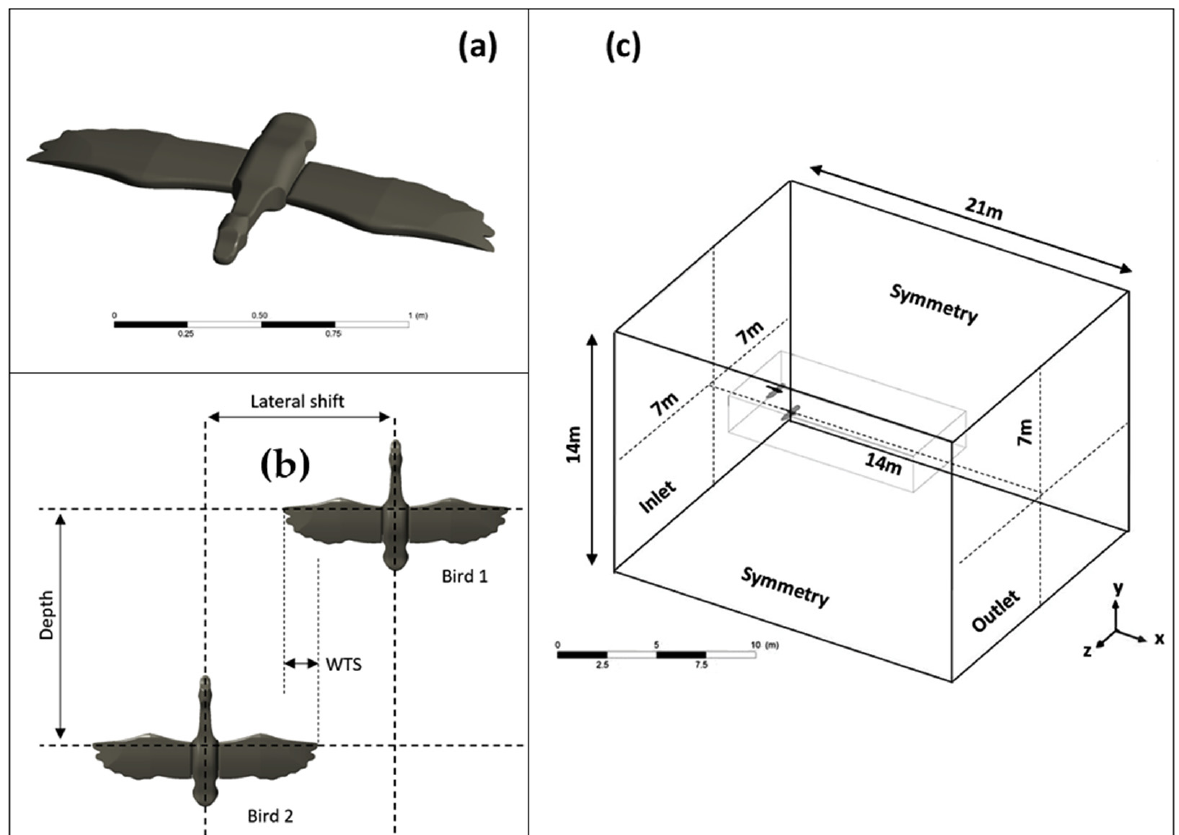
Figure 1. ( a ) Simplified geometry of the Canada goose. ( b ) Positioning of the birds in relation to each other. ( c ) Computational domain size and boundary conditions. Table 1. Main CFD parameters and dimensional characteristics of a Canada goose [25,27]. Numerical conditions are determined assuming that the bird flies at an altitude of 1000 m